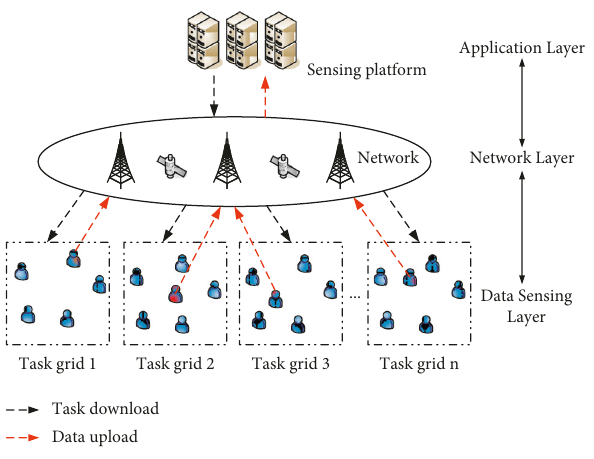
Figure 1: Structure of the mobile crowd sensing